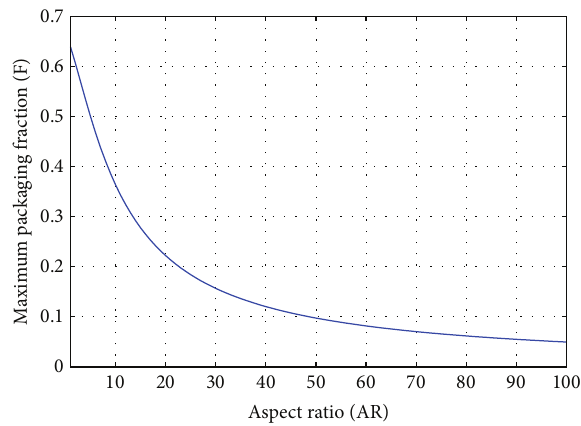
Figure 5: DC electrical conductivity of the nanocomposite at varying the conductivity of the filler (Kirkpatrick’s model).